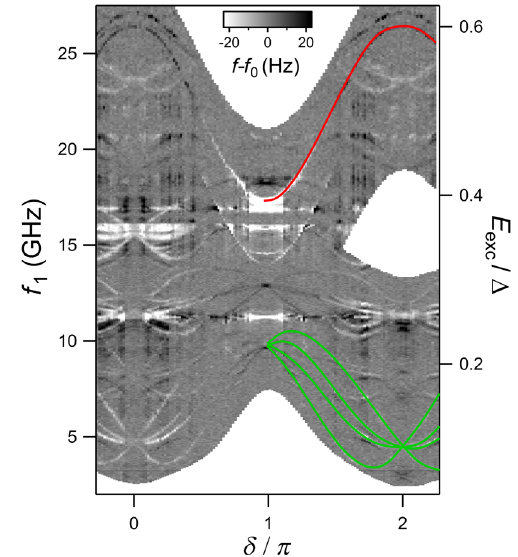
FIG. 3. Microwave excitation spectrum measured at a gate ¼ − 0 . 89 V. The gray scale represents the frequency voltage V g change f − f 0 of a resonator coupled to the weak link when a microwave excitation at frequency f 1 is applied as a function of the phase difference δ across the weak link. In the right half of the figure, some transition lines are highlighted. Red line corresponds to a pair transition; green lines are single-particle